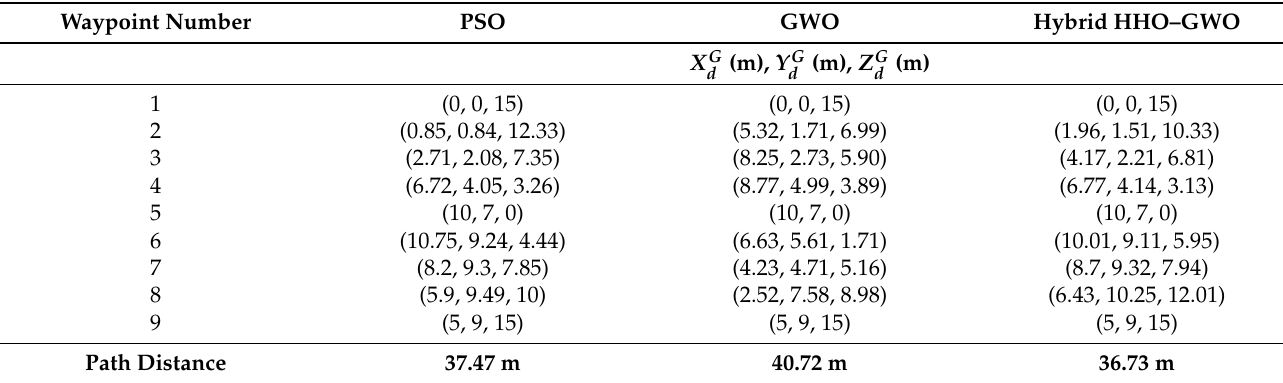
Table 3. Optimized waypoints for Scenario